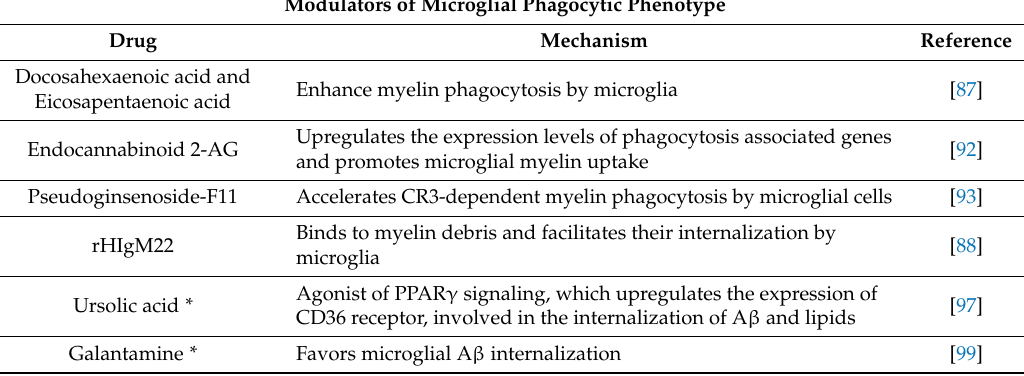
List of possible drugs to modulate microglia towards a regenerative phenotype in multiple